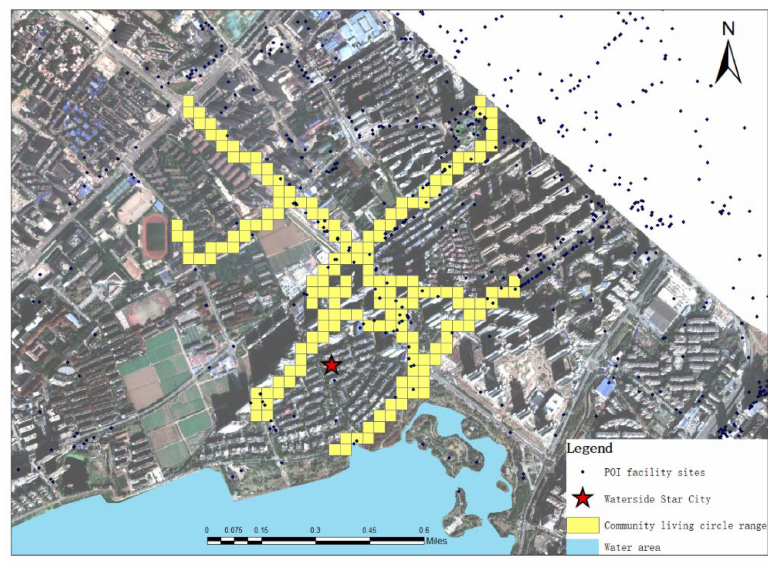
Figure 7. Waterside Star City 15 min-CLC coverage.